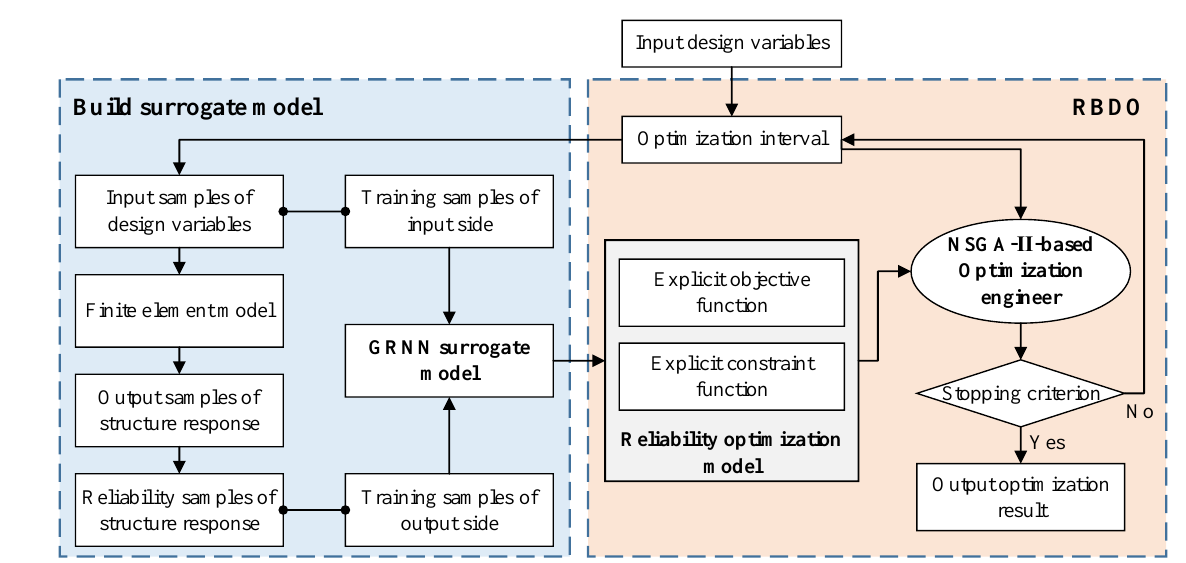
Figure 6. Flowchart of the surrogate-assisted RBDO.